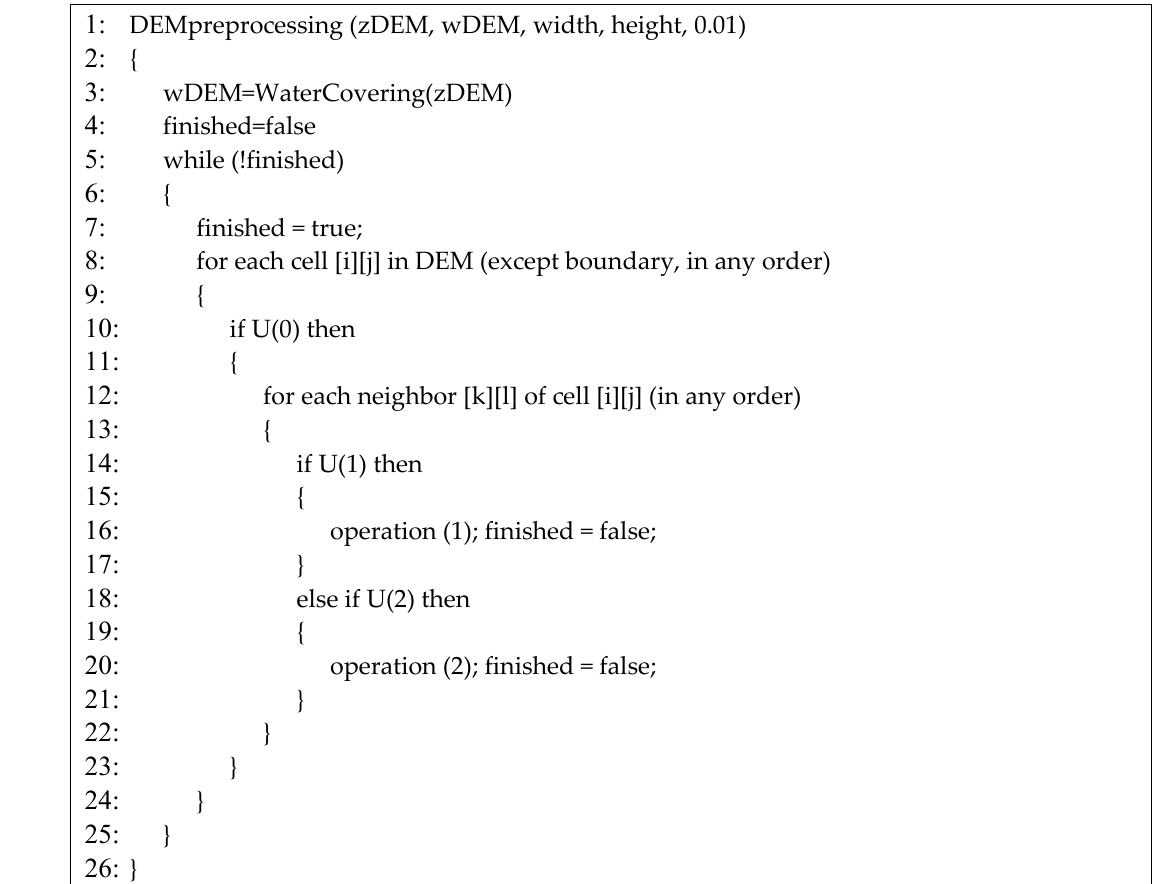
Figure 4. Pseudo code of the DEM preprocessing algorithm.